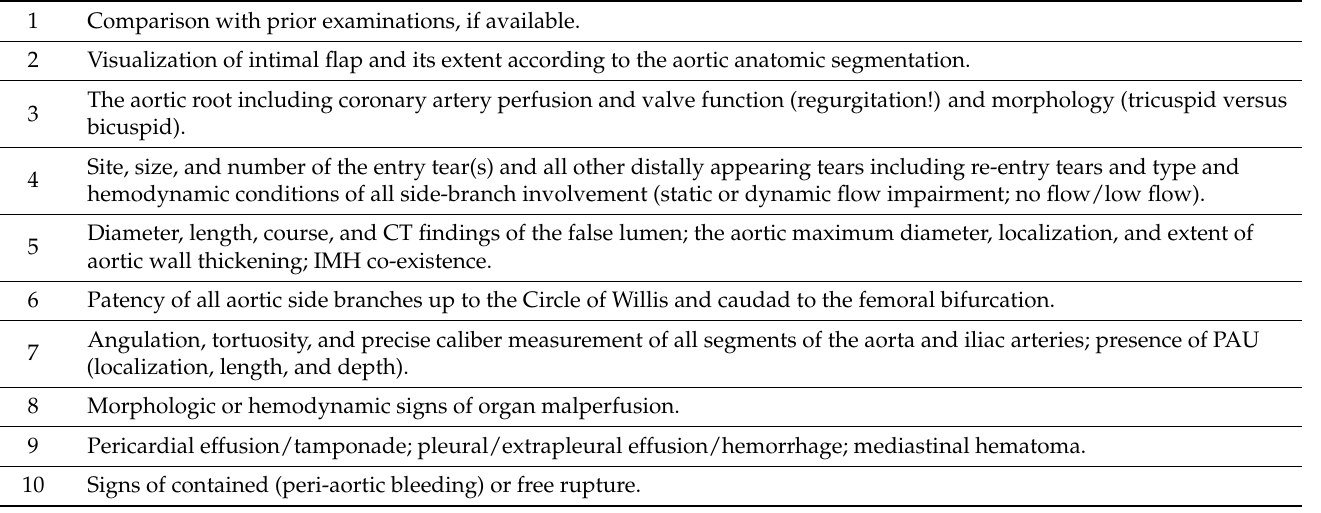
Table 3. Complete list of morphologic features in AAS that need to be covered by imaging. The Ten Commandments in